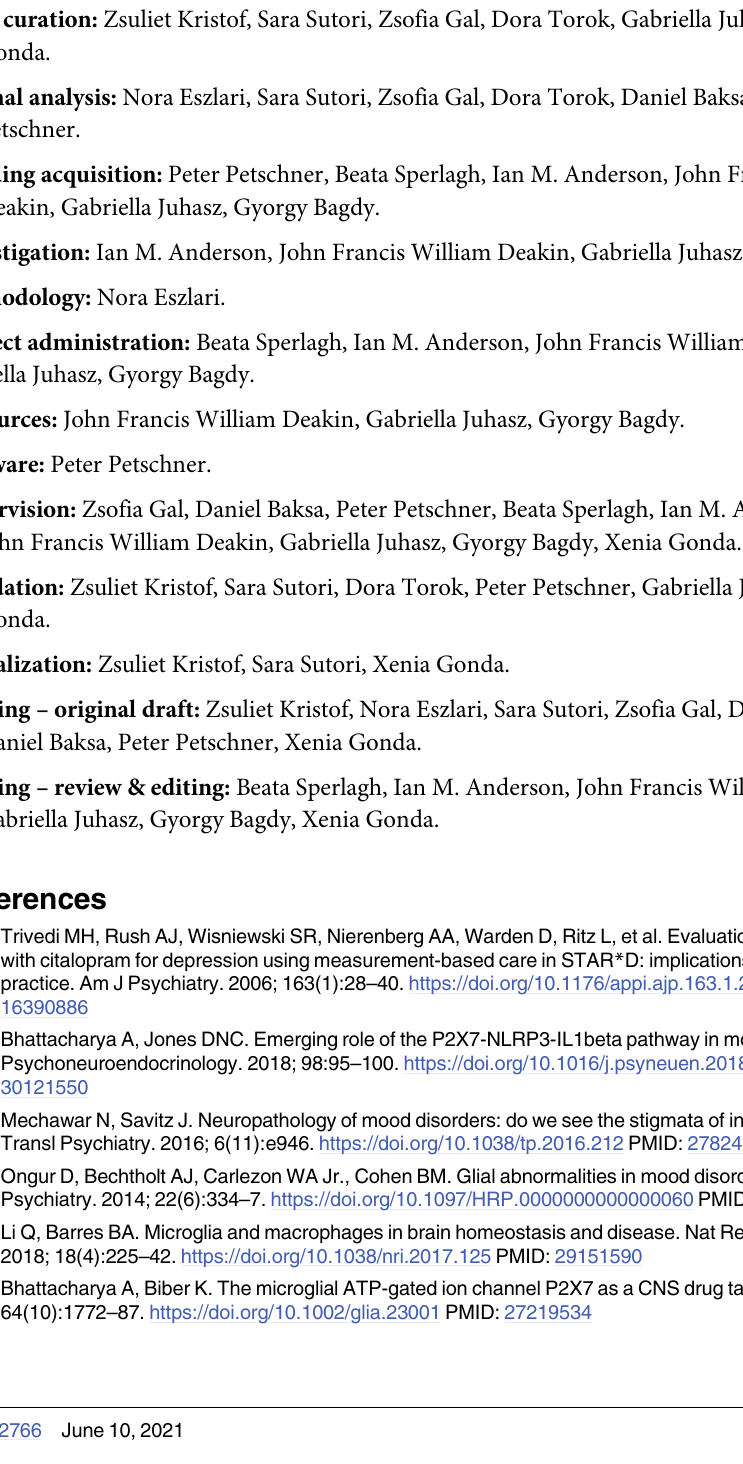
S2 Table. P2RX7 SNPs in the NewMood database in interaction with recent life events (RLE) with results in quality control steps and linear regression for